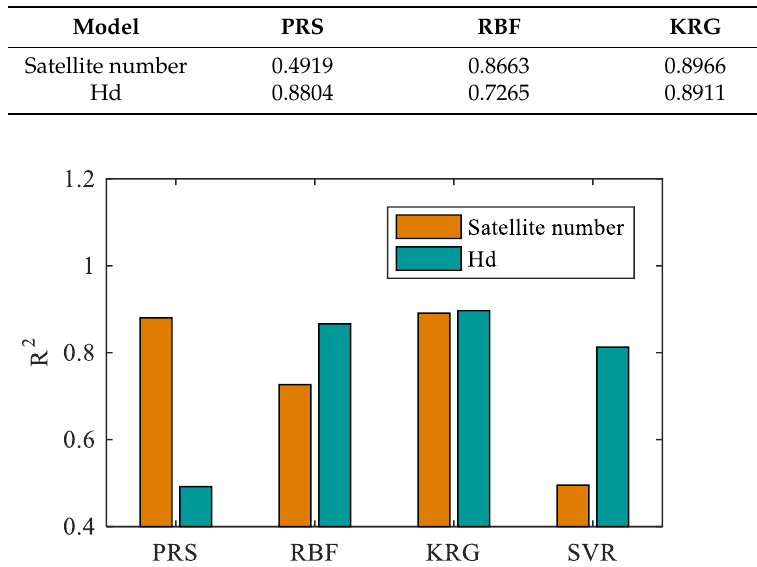
Figure 10. Errors of different surrogate models.